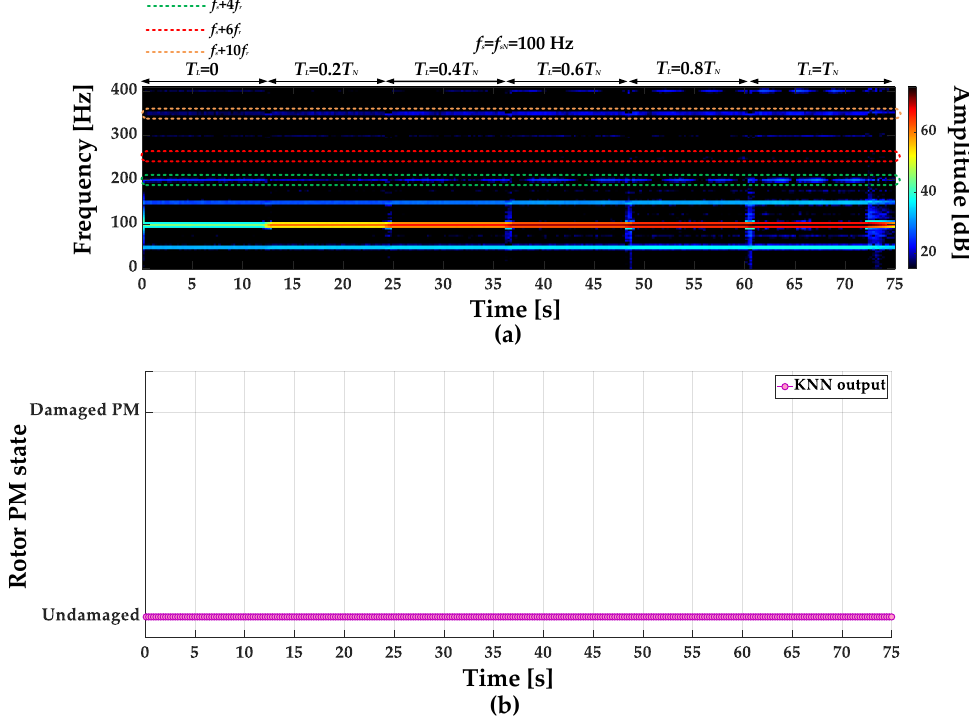
Figure 19. ( a ) Part of the stator phase current STFT spectrogram, ( b ) response of the KNN-based fault detector for undamaged rotor ( T L = var, f s = f sN = 100 Hz).